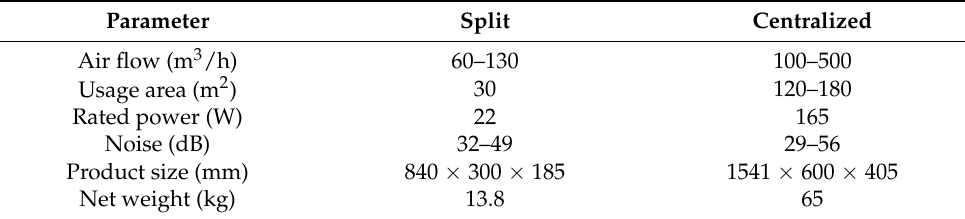
Figure 2. Schematics of the ( a ) split and ( b ) centralized mechanical ventilation systems in buildings. Table 1. Parameters of mechanical ventilation system.